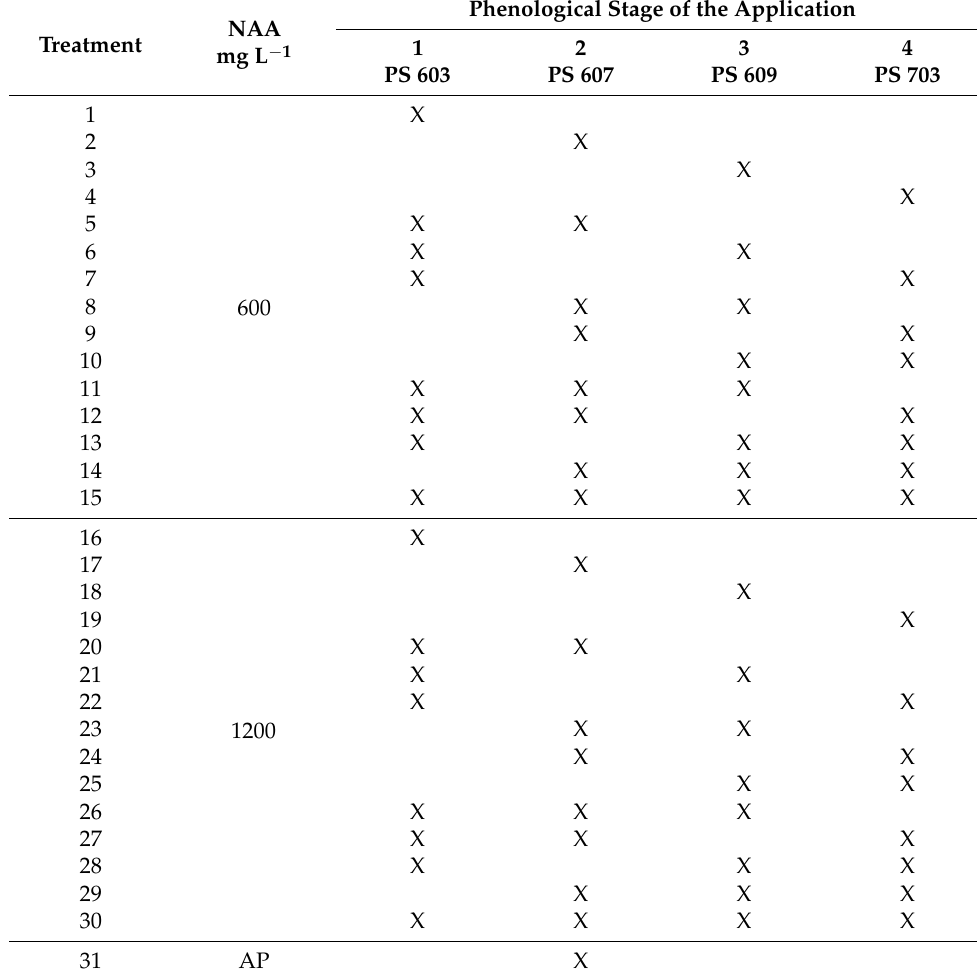
Table 2. Treatments for the definition of best naphthalene acetic acid (NAA) concentration and application frequency to induce parthenocarpy in OxG hybrids (Coari x La M é ). NAA solutions were applied one, two, three, or four times at different phenological stages. Assisted pollination treatment was performed only in inflorescences in anthesis (phenological stage 607). Phenological Stage of the NAA Treatment mg L − 1